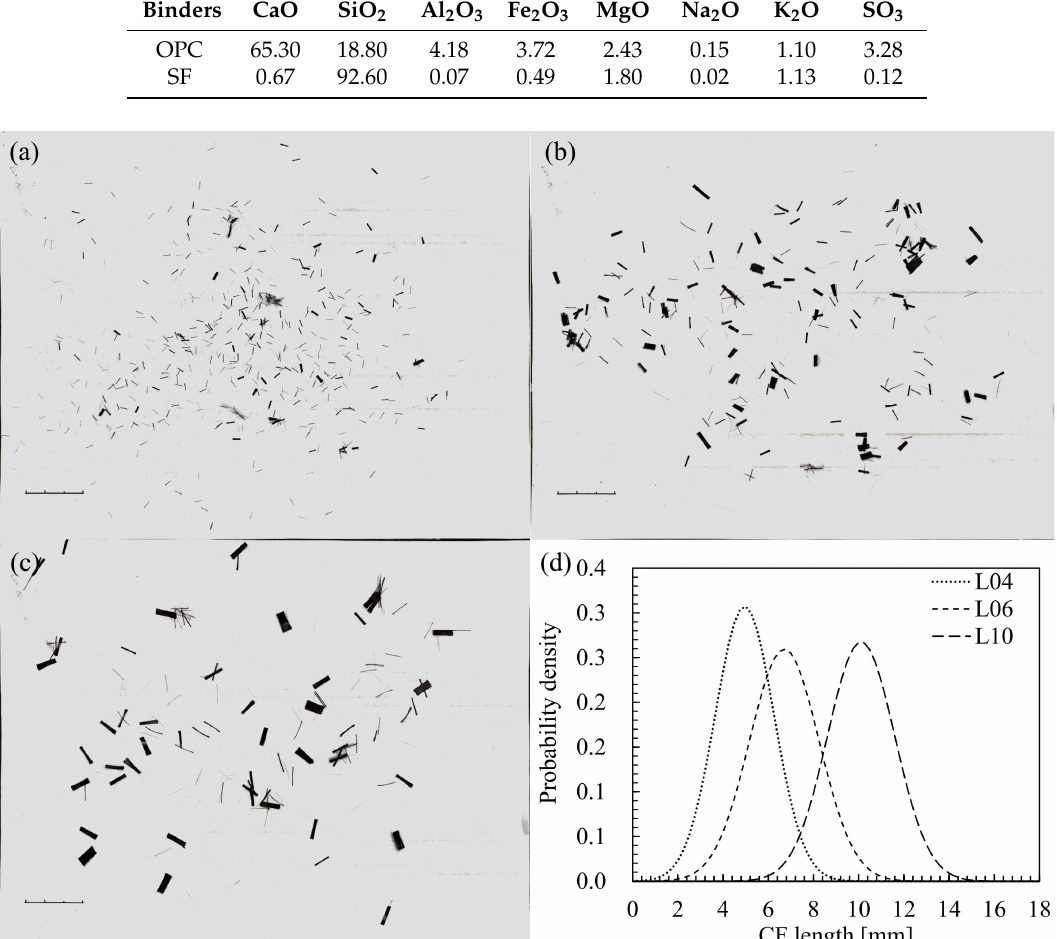
Figure 1. Carbon fiber (CF) bundles with di ff erent lengths and their length verifications; ( a ) 4 mm CF (L04), ( b ) 6 mm CF (L06), ( c ) 10 mm CF (L10), and ( d ) probability density of the di ff erent CF lengths obtained by image